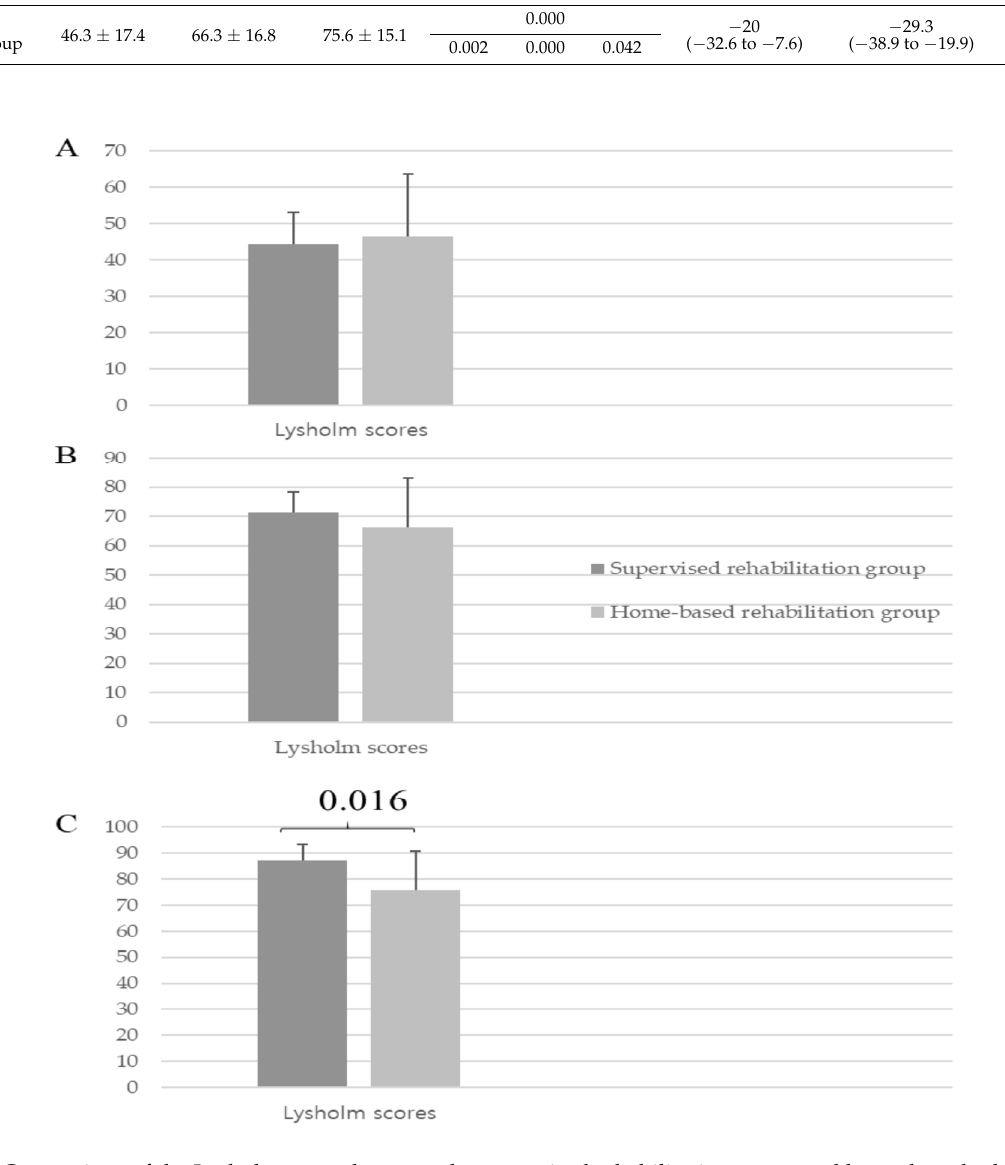
Figure 4 . Comparison of the Lysholm scores between the supervised rehabilitation group and home-based rehabilitation group. ( A ) Preoperative baseline, ( B ) At postoperative 6 months, and ( C ) At postoperative 1 year.